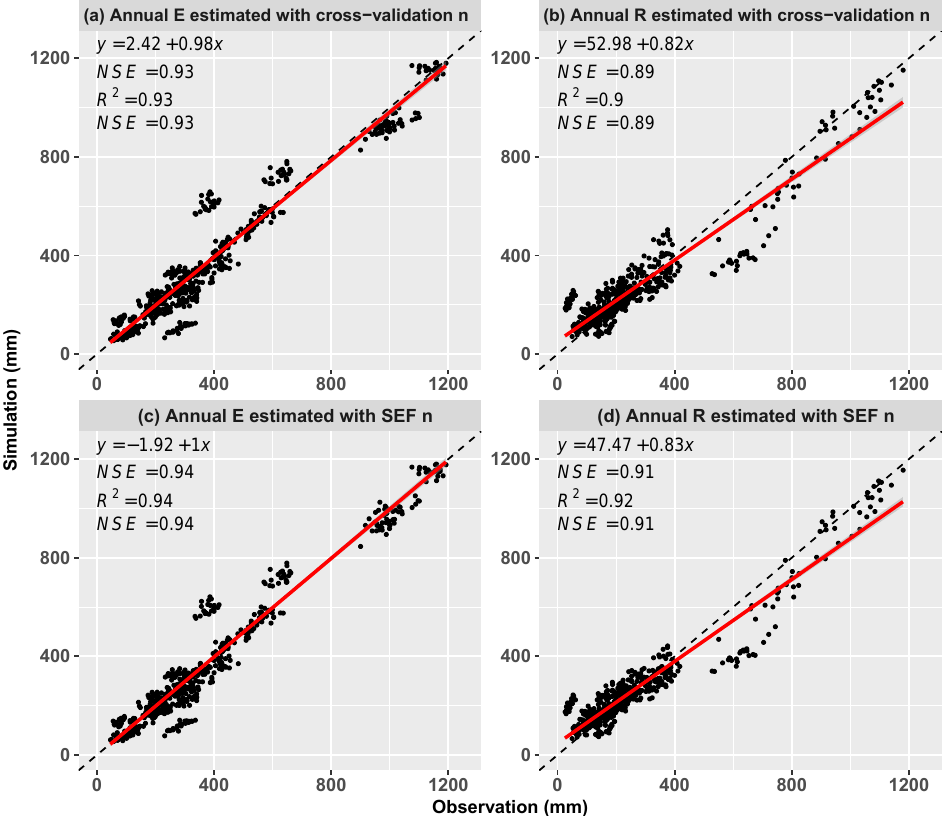
Figure 7. The observed E and R vs. the simulated E and R estimated by Budyko model with simulated parameter n by (a–b) Eq. (13) with cross-validation method and (c–d) semi-empirical formula (SEF, Eq. 14).